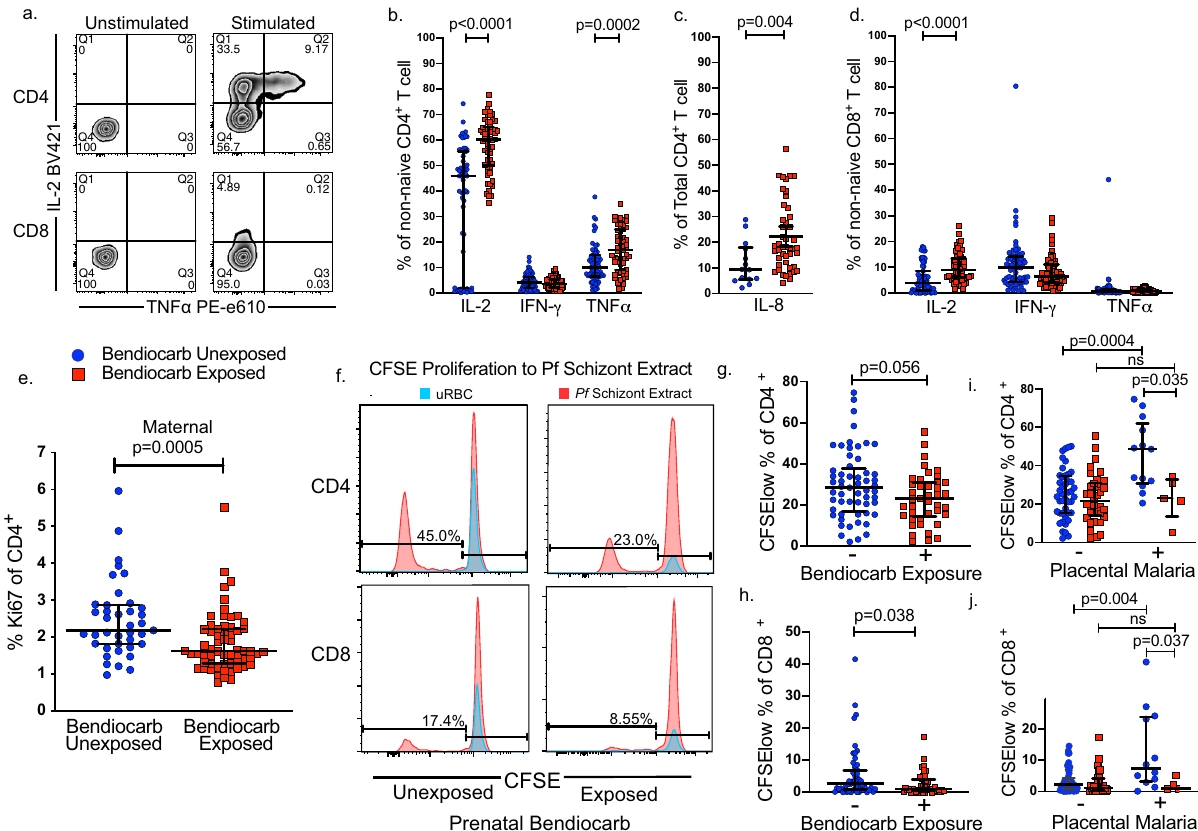
Fig. 3 The T cell in fl ammatory response is enhanced but proliferation to malaria antigen stimulation is inhibited in bendiocarb-exposed maternal and cord blood. a A representative fl ow plot demonstrating the production of IL-2 and TNF α by non-naive cord blood CD4 and CD8 T cells following stimulation with PMA/io. b Frequencies of cytokine-producing cord blood non-naive CD4 T cells for IL-2, IFN- γ , and TNF α following stimulation with PMA/ io in exposed (red, n = 57) and unexposed (blue, n = 63) infants. c Frequencies of cytokine-producing cord blood total CD4 T cells for IL-8 following stimulation with PMA/io in exposed (red, n = 46) and unexposed (blue, n = 14) infants. d Frequencies of cytokine-producing cord blood non-naive CD8 T cells following stimulation with PMA/io in exposed (red, n = 57) and unexposed (blue, n = 63) infants e Frequencies of maternal CD4 T cells expressing the proliferation marker Ki67 in exposed (red, n = 61, red) and unexposed (blue, n = 39) mothers. f Cord blood T cells were stimulated with P. falciparum schizont extract (red) or uninfected red blood cells (uRBCs, blue) and proliferation was measured by dilution of CFSE in CD4 and CD8 T cells. A representative plot of CD4 and CD8 T cell proliferation in a bendiocarb-unexposed (left) and exposed (right) infant. Frequency represents CFSE dilution to stimulus prior to background subtraction. g , h CD4 and CD8 T cell proliferation in response to PfSE was lower in infants prenatally exposed to bendiocarb in exposed (red, n = 41) and unexposed (blue, n = 57) infants. i , j When strati fi ed by active placental malaria, CD4 and CD8 T cell proliferation to PfSE was robust in bendiocarb-unexposed infants, but ablated in bendiocarb-exposed infants ( n = 98). All comparisons use Wilcoxon rank-sum test. Bars indicate median with interquartile range. Two-sided p values were calculated for all test statistics. Evaluation for malaria . Tororo is a holoendemic region in which malaria occurs year-round. Mothers were evaluated for malaria parasitemia every 4 weeks by loop- mediated isothermal ampli fi cation (LAMP). Febrile episodes were evaluated by blood microscopy and, if positive, treated for malaria per local guidelines. Placentas were evaluated by microscopy, LAMP, and histopathology 16 . Infants were cate- gorized as malaria-exposed in utero if their mothers had any positive testing for malaria during pregnancy or at delivery, or evidence of placental malaria by his- topathology. Active placental malaria was de fi ned by a positive LAMP assay of placental blood.